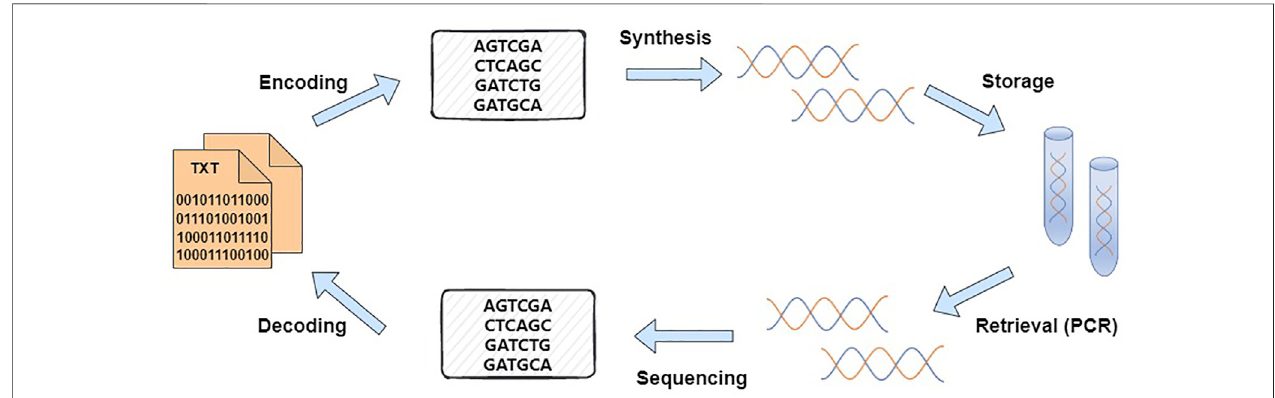
FIGURE 1 | Overall schematic of DNA